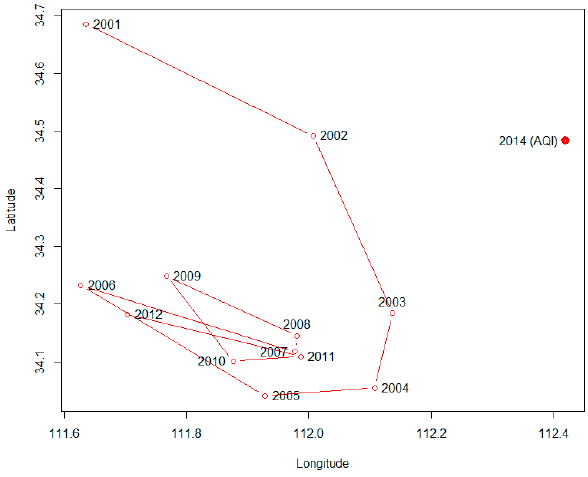
Figure 6. The shift of the API gravity center from 2001–2012.